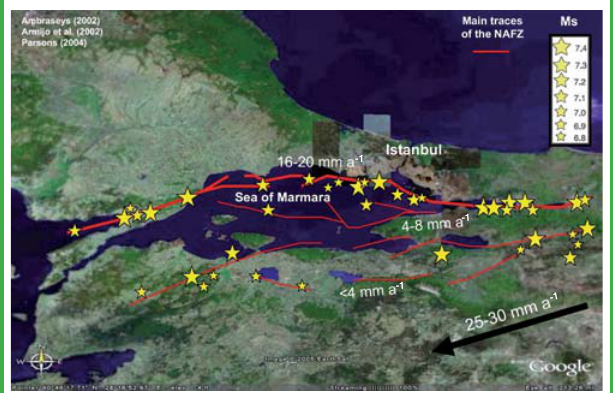
Figure 1. Google Earth® view of the Sea of Marmara, Istanbul region. Red lines indicate major segments of the North Anatolian Fault zone. Stars indicate main shocks M>6.5 that occurred in the last 2000